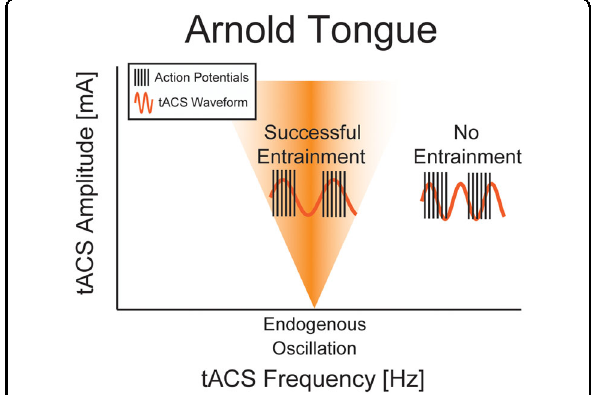
Fig. 1 Successful neural entrainment from tACS is dependent on the Arnold Tongue. tACS entrains neural oscillations (represented as vertical lines symbolizing action potentials) by a mechanism referred to as the Arnold tongue, which references the inverted triangle shape of the parameter combinations (amplitude, frequency) that allow successful entrainment, i.e. synchronization of neural activity to the rhythmic stimulation waveform.The higher the stimulation amplitude, the more detuning (i.e., mismatch) of the stimulation frequency relative to the endogenous oscillation frequency is allowed to still achieve entrainment. Given the low amplitude of the perturbation to the neuronal membrane voltage by tACS, tuning of the stimulation waveform appears to be an important aspect of rational design of the stimulation waveform. Future tACS clinical trials should apply sine- wave stimulation waveforms that are matched to the endogenous frequency of the targeted oscillation determined by EEG. To what extent this principle predicts outlasting effects of tACS remains unclear given that there is no published preclinical model of these effects and that an attempt to investigate the role of entrainment in the outlasting effects was negative 39